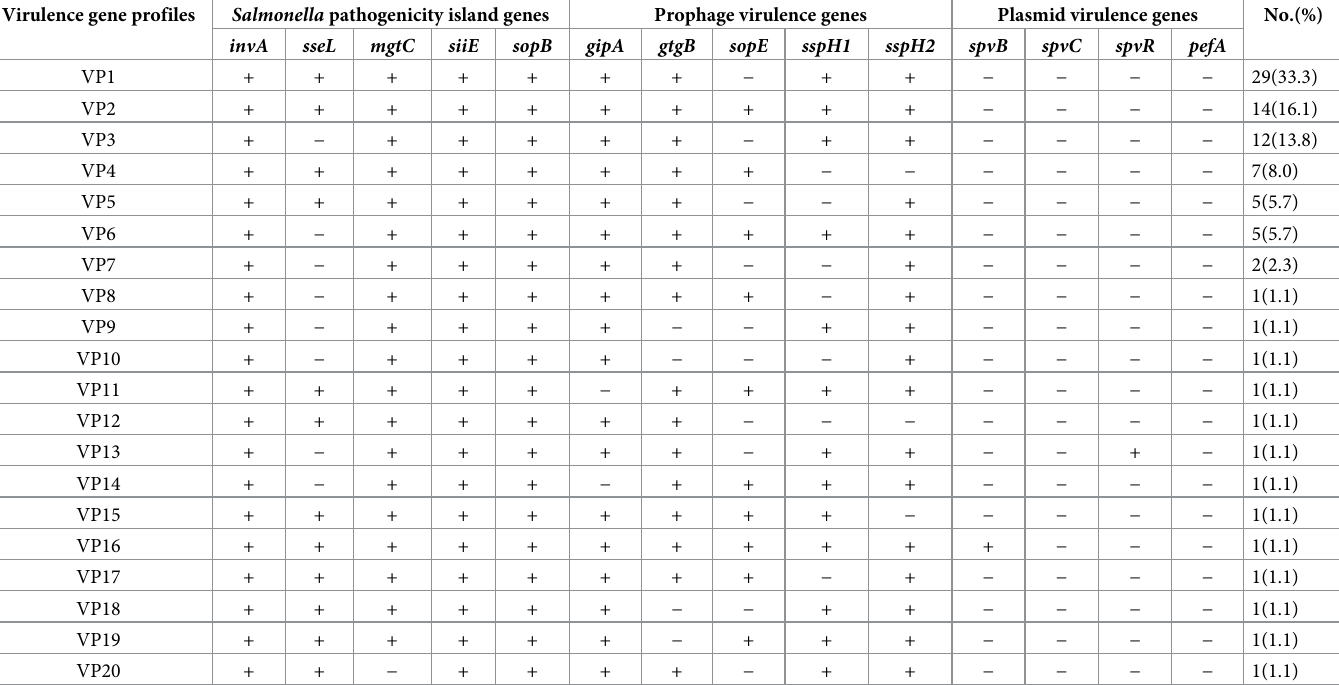
Table 4. Virulence gene profiles of the Salmonella 4,[5],12:i:- isolates. Virulence gene profiles Salmonella pathogenicity island